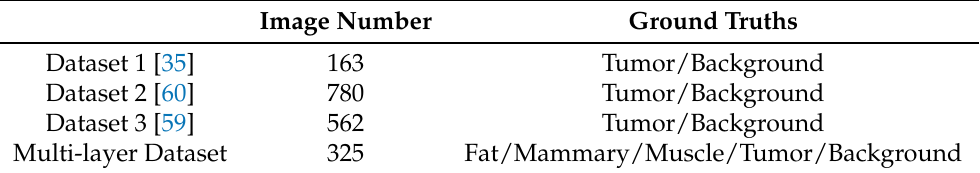
Table 1. Dataset